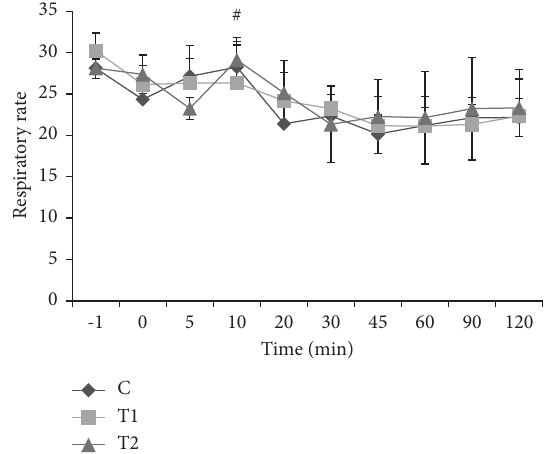
Figure 3: Changes in the respiratory rate in the studied groups before and after induction of anesthesia. All values are presented as the mean ± standard error of the mean (mean ± SEM). # indicates a significant difference within the